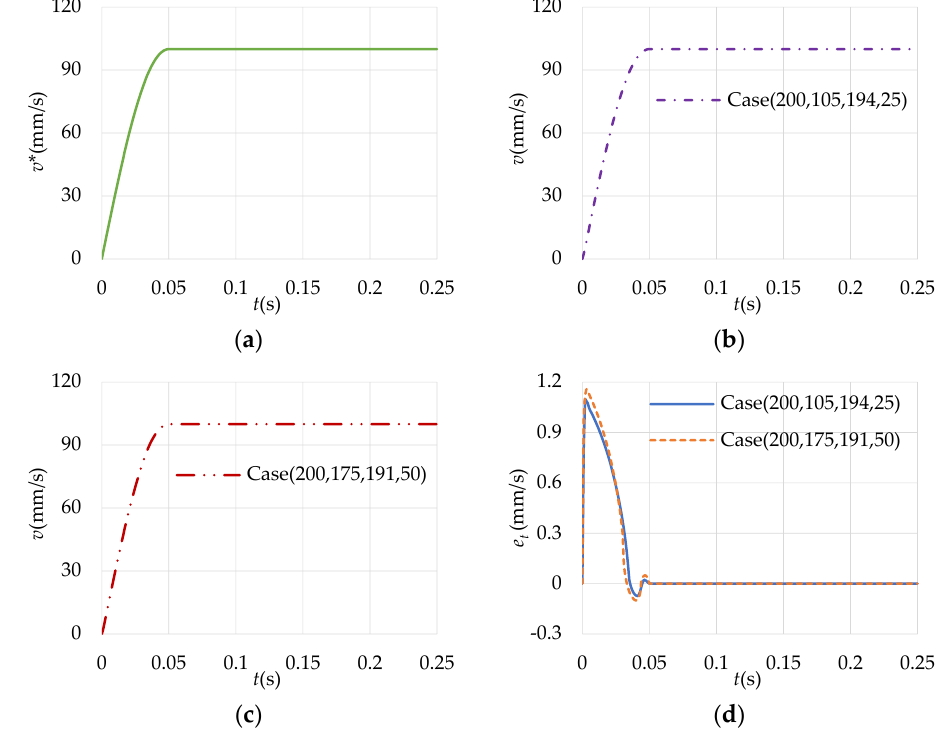
Figure 7. v *( t ), v t ( t ), and e t ( t ), ( a ) v *( t ), ( b ) v t ( t ) of Case (200, 105, 194, 25), ( c ) v t ( t ) of Case (200, 175, 191, 50), ( d ) e t ( t ) of Case (200, 105, 194, 25) and Case (200, 175, 191, 50).